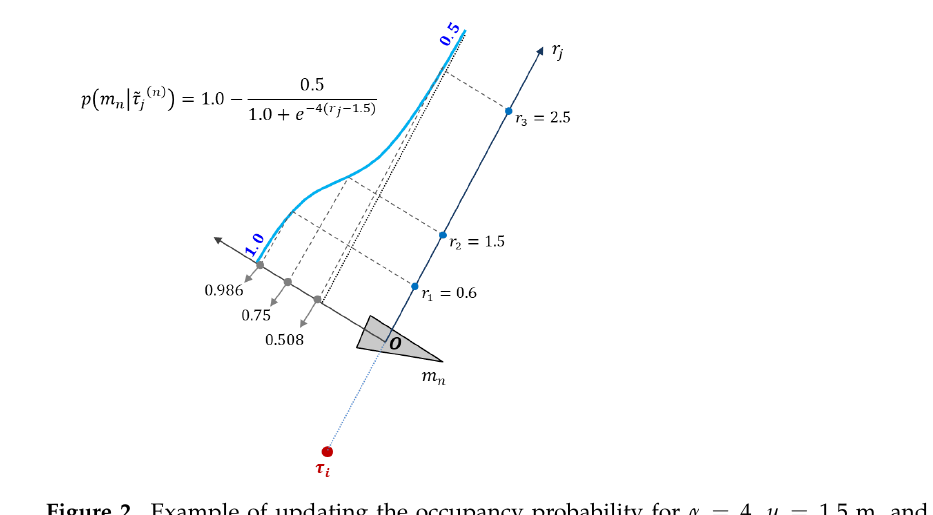
Figure 2. Example of updating the occupancy probability for α = 4, µ = 1.5 m, and r ( 1,2,3 ) = ( 0.6,1.5,2.5 ) m for ˜ τ ( m n | ˜ τ ) is ( 1.848,0.477,0.014 ) ( 1,2,3 ) j in (7). The resulting p